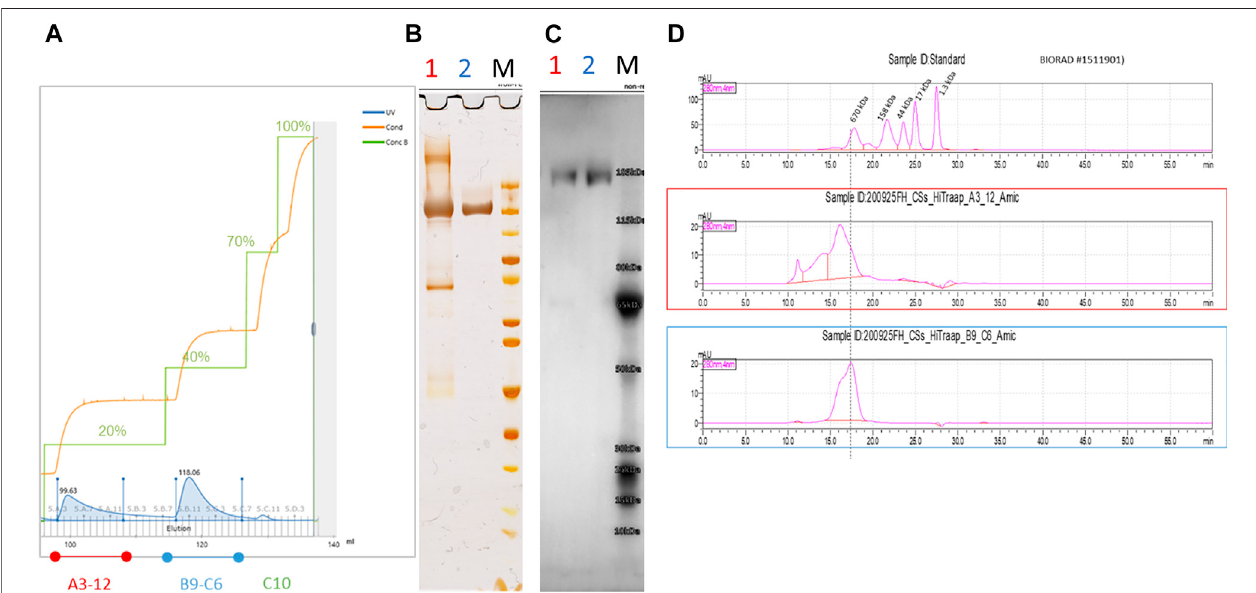
FIGURE7| IMACpuri fi cationofspikeproteinusinga20% – 40% – 70% – 100%stepgradientprotocol (A) .Spikeproteinelutedat40%(B9-C6)providedhighlypure and functionalfractions veri fi edbynon-reducing SDS-PAGE/Silverstaining (B) andWesternblottingagainsthyperimmuneIgG (C) .Acorrectbandsizeofapproximately 180 kDa was obtained, which would be expected for a denatured monomeric CSs protein chain. Polyclonal antibodies against the spike protein were isolated from hyperimmuneserabycryo-andammoniumsulfateprecipitation,followedbyproteinAaf fi nitychromatographyandbiotinylationforWesternblotting.AnalyticalSEC analysis con fi rmed the high purity of fraction B9-C6 (blue) with only the characteristic peak visible (D) .